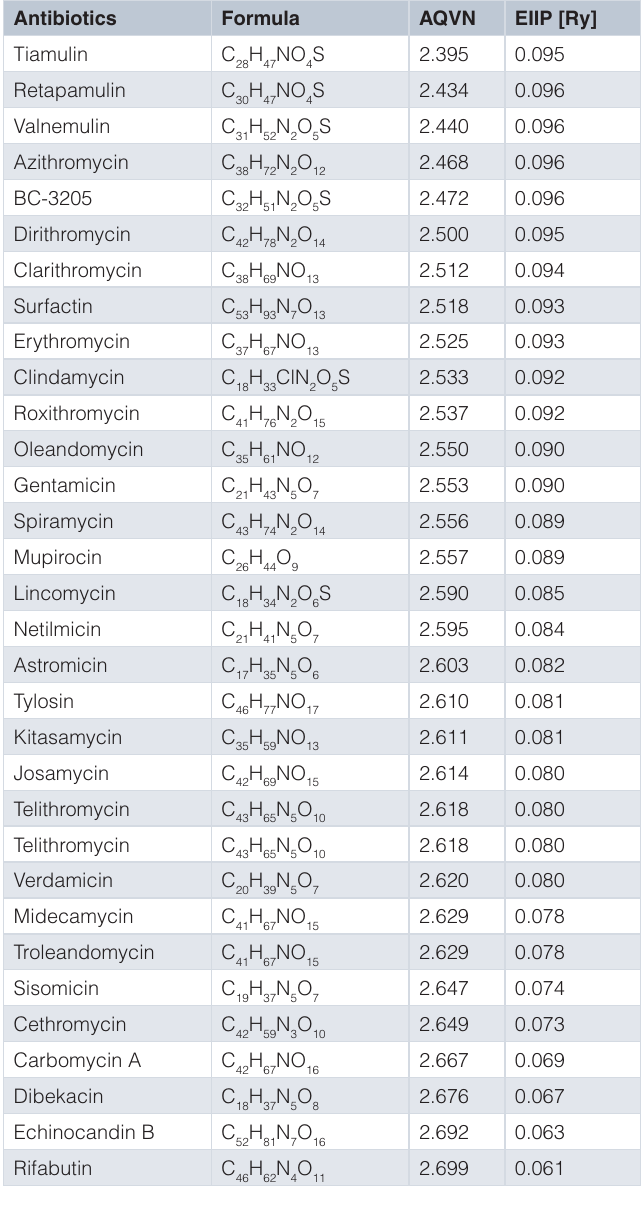
Table 5. Antibiotics selected as candidate drugs for EVD.